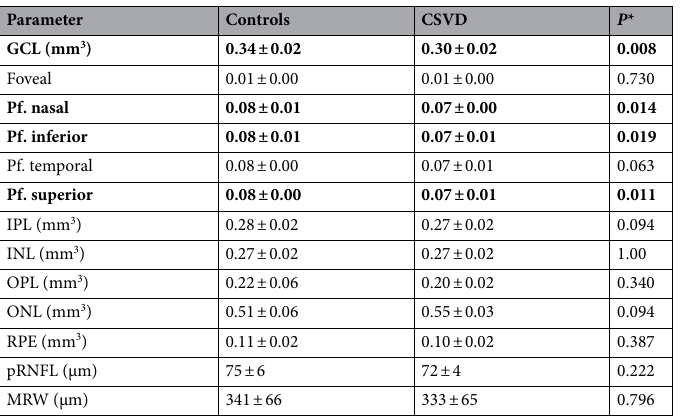
Table 2. Comparison of structural retinal parameters between patients with cerebral small vessel disease and age-matched controls. Values are mean ± SD and the volumes of the macular layers correspond to the foveal and parafoveal volumes (3-mm-circle). *Mann–Whitney-U-test was performed to compare the two groups. Significant results ( p < 0.05) are displayed in bold. CSVD, patients with cerebral small vessel disease; GCL, ganglion cell layer; pf., parafoveal; IPL, inner plexiform layer; INL, inner nuclear layer; OPL, outer plexiform layer; ONL, outer nuclear layer; RPE, retinal pigment epithelium; pRNFL, peripapillary retinal nerve fiber layer; MRW, Bruch’s membrane opening-minimum rim width.